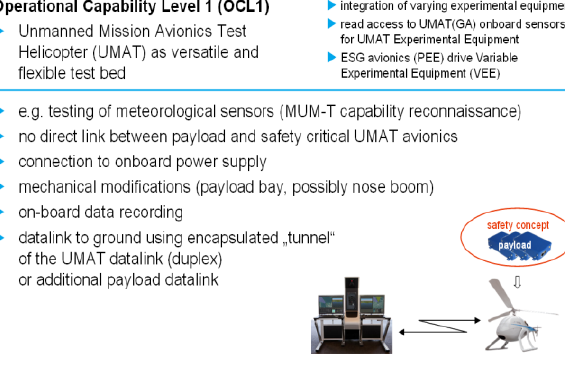
Fig. 7 Depiction of UMAT Operational Capability Level 1 Fig. 8 Depiction of UMAT Operational Capability Level 2